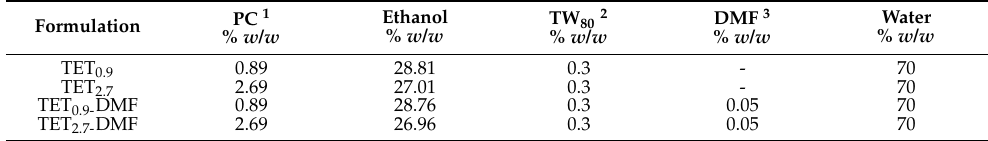
Table 1. Composition of transethosomes.